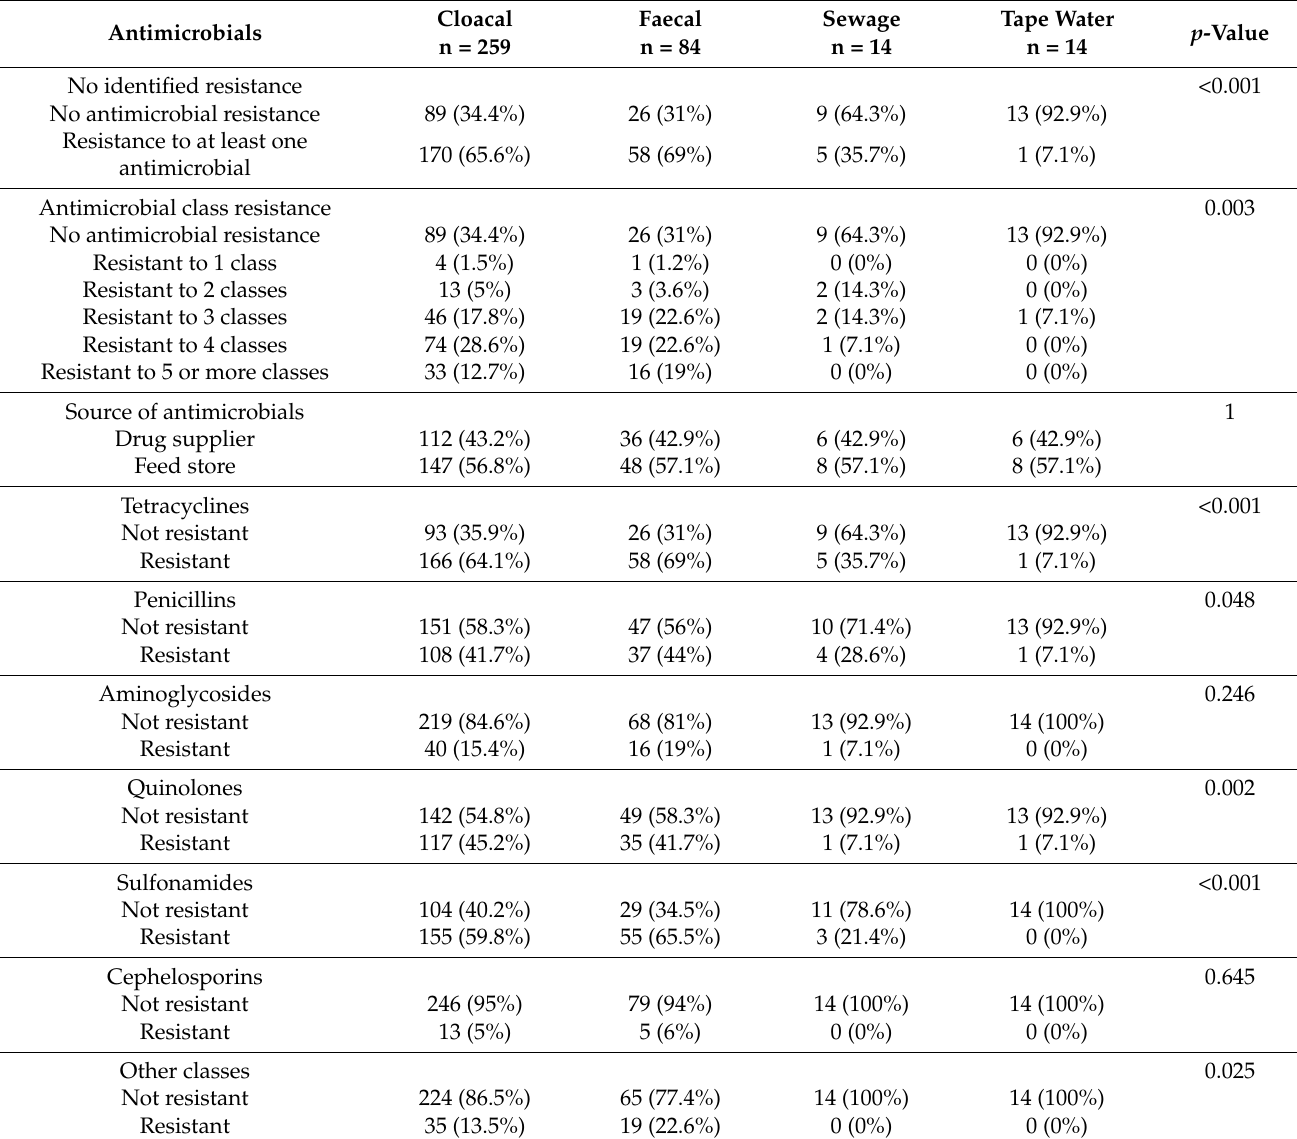
Table 3. Summary of univariate analysis of poultry samples for antimicrobial-resistant E. coli from poultry farms in east coast of Malaysia (n = 371